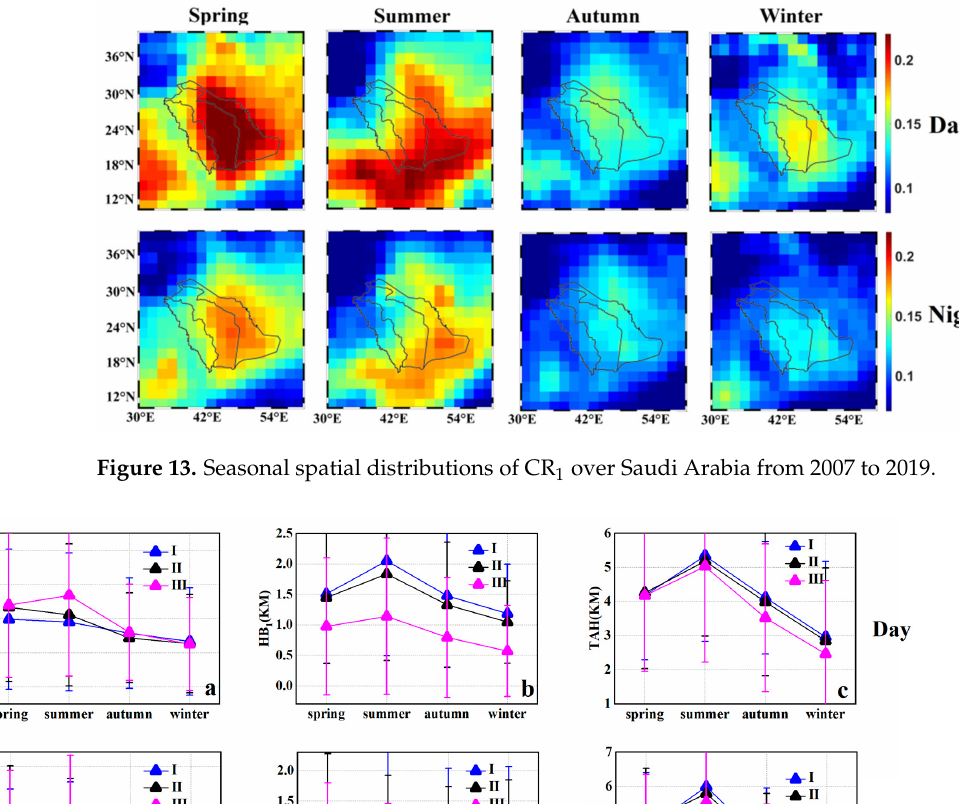
Figure 12. Seasonal spatial distributions of VDR 1 over Saudi Arabia from 2007 to 2019.